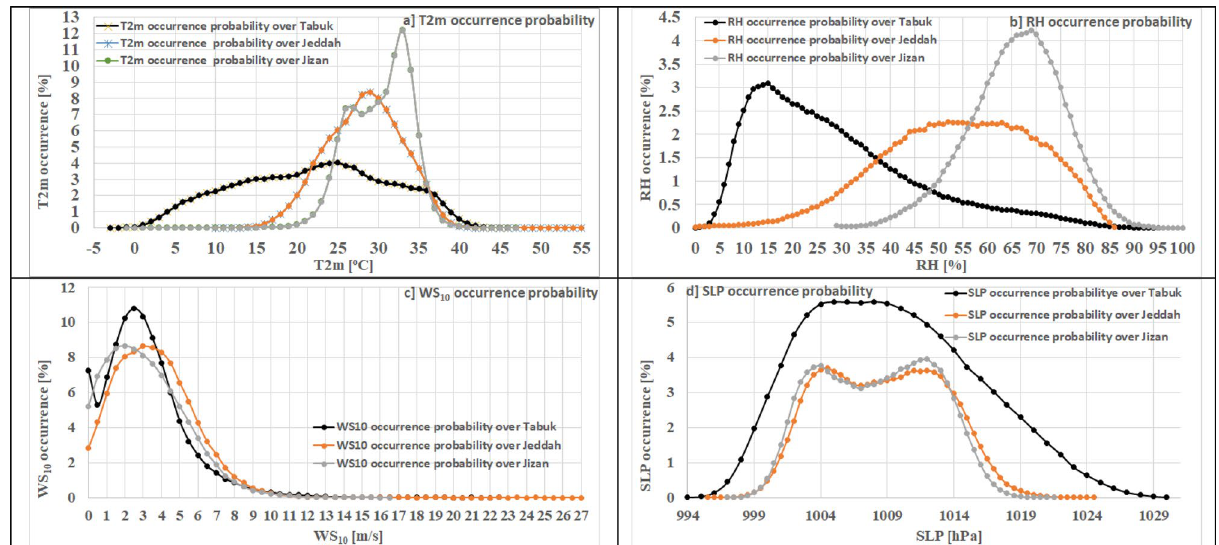
Figure 10. Occurrence probability of the parameters considered based on the hourly corrected ERA5 data (1979–2020) in the study area. Math Works, Inc. MATLAB. Version 2020a, Math Works, Inc., 2020. www. mathw orks.